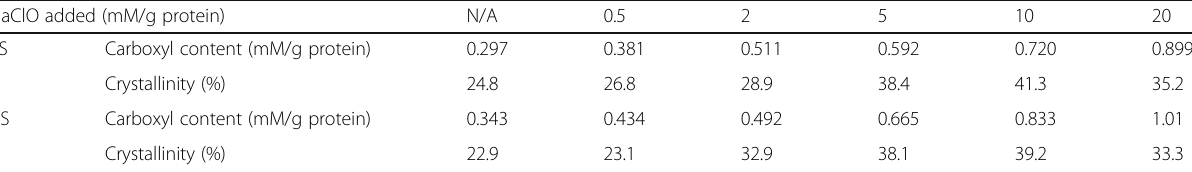
Table 1 The crystallinity and carboxyl content of BS and AS pulp after oxidation with various NaClO addition NaClO added (mM/g protein) N/A 0.5 BS Carboxyl content (mM/g protein)